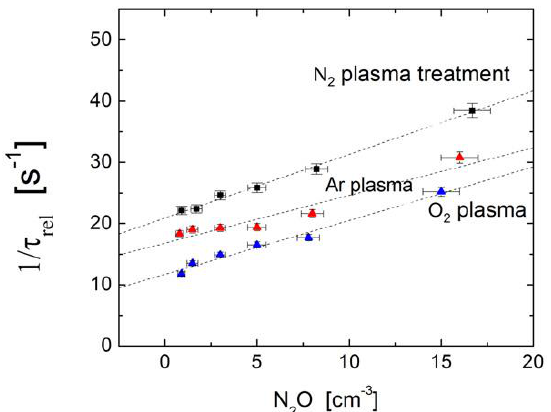
Figure 11. Effective relaxation frequency 1/ τ rel in a silica reactor, pretreated with a N 2 , O 2 or argon plasma, as a function of the concentration of the IR tracer N 2 O [52], © IOP Publishing. Reproduced with permission. All rights reserved.